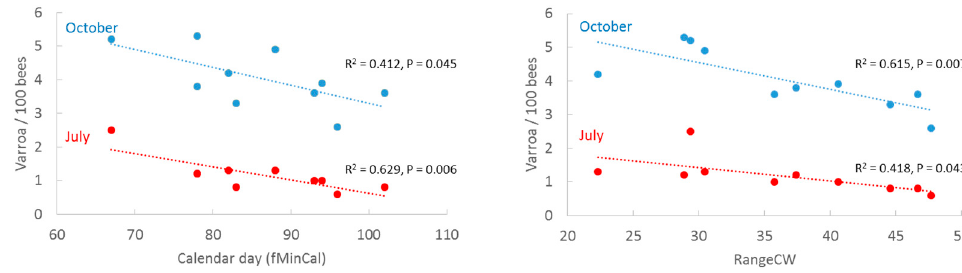
Figure 6. Annual average infestation levels of V. destructor per 100 bees in Germany (2012–2021) in July and October [15] as a function of calendar day of first minimum cumulative weight (fMinCal) and range of cumulative weight (RangeCW).